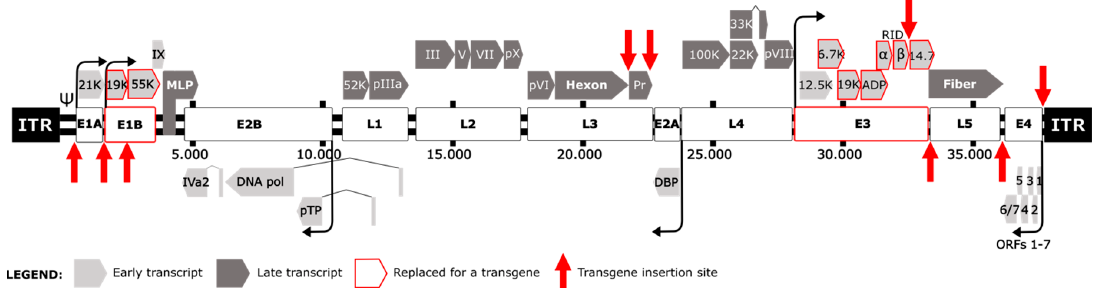
Figure 1. Schematic representation of adenovirus genome. Light grey represents early transcripts (E1A, E1B, E2A, E2B, E3 and E4) and dark grey the late transcripts (L1, L2, L3, L4 and L5) produced by alternative splicing under the major late promoter (MLP). Published insertion sites and replaced adenoviral genes are reported according to the legend.